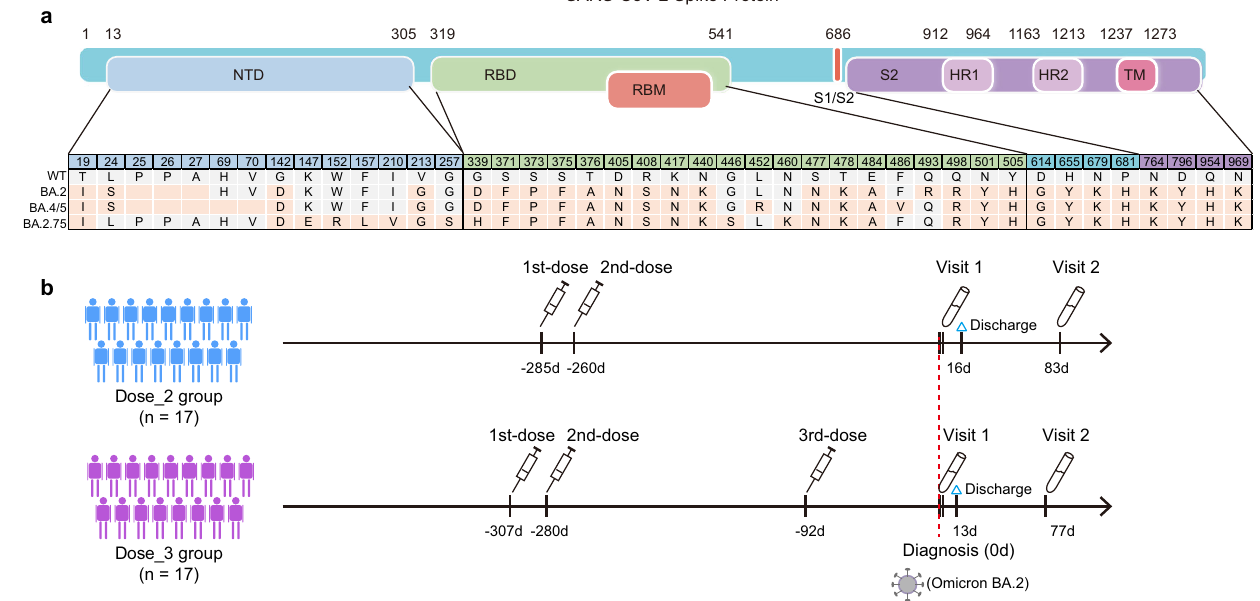
Fig. 1 | SARS-CoV-2 Omicron subvariants and BA.2 breakthrough infection cohorts involved in this study. a Mutations located in spike protein were identi- fi ed in Omicron subvariants including BA.2, BA.4/5, and BA.2.75. Amino acid resi- dues consistent with WT SARS-CoV-2 were marked in gray, and mutations in Omicron subvariants were marked in orange. b Schematic overview of study